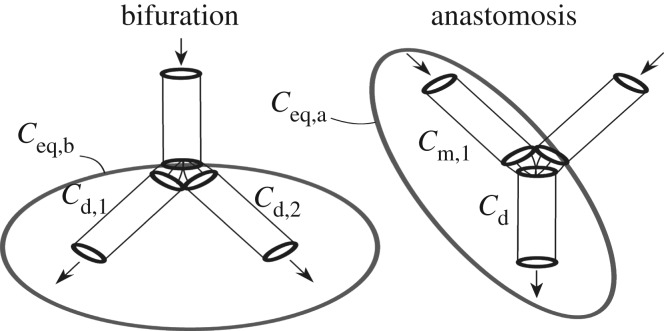
Compliance contribution from vessels in bifurcations and anastomosis used in equation (A6a) and equation (A6b). Arrows indicate the direction of flow.